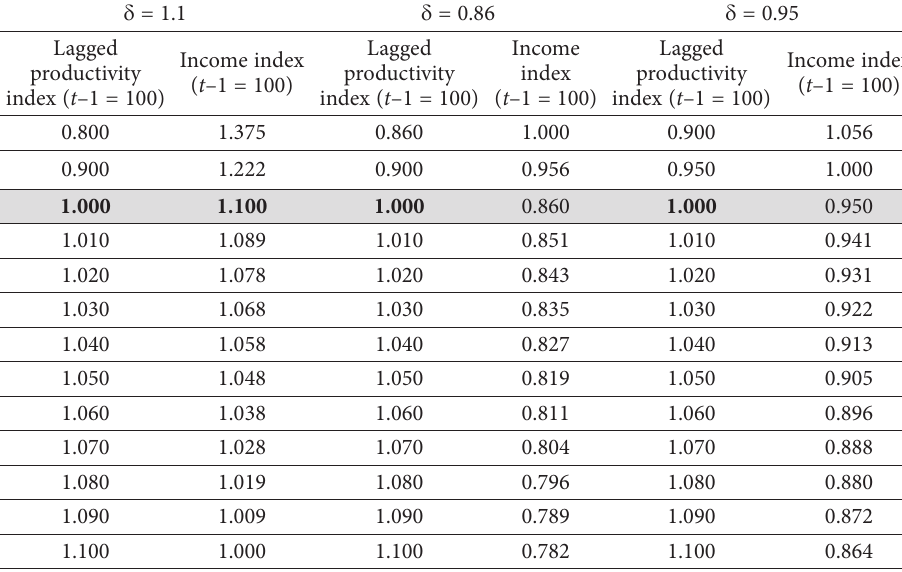
Table 10. Simulations of changes in real productivity and incomes on the basis of estimated d para- meters (functions No. 2, 3, 5, under ceteris paribus conditions) d = 1.1 d = 0.86 d = 0.95 Lagged